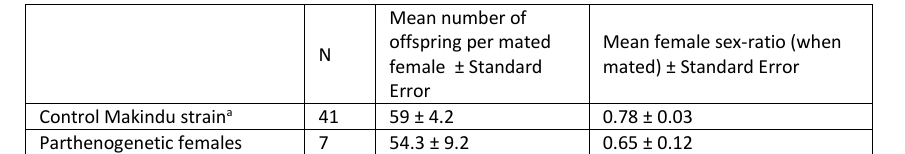
Table 3: Comparison of the fecundity between Makindu parthenogenetic females and control females of the same laboratory